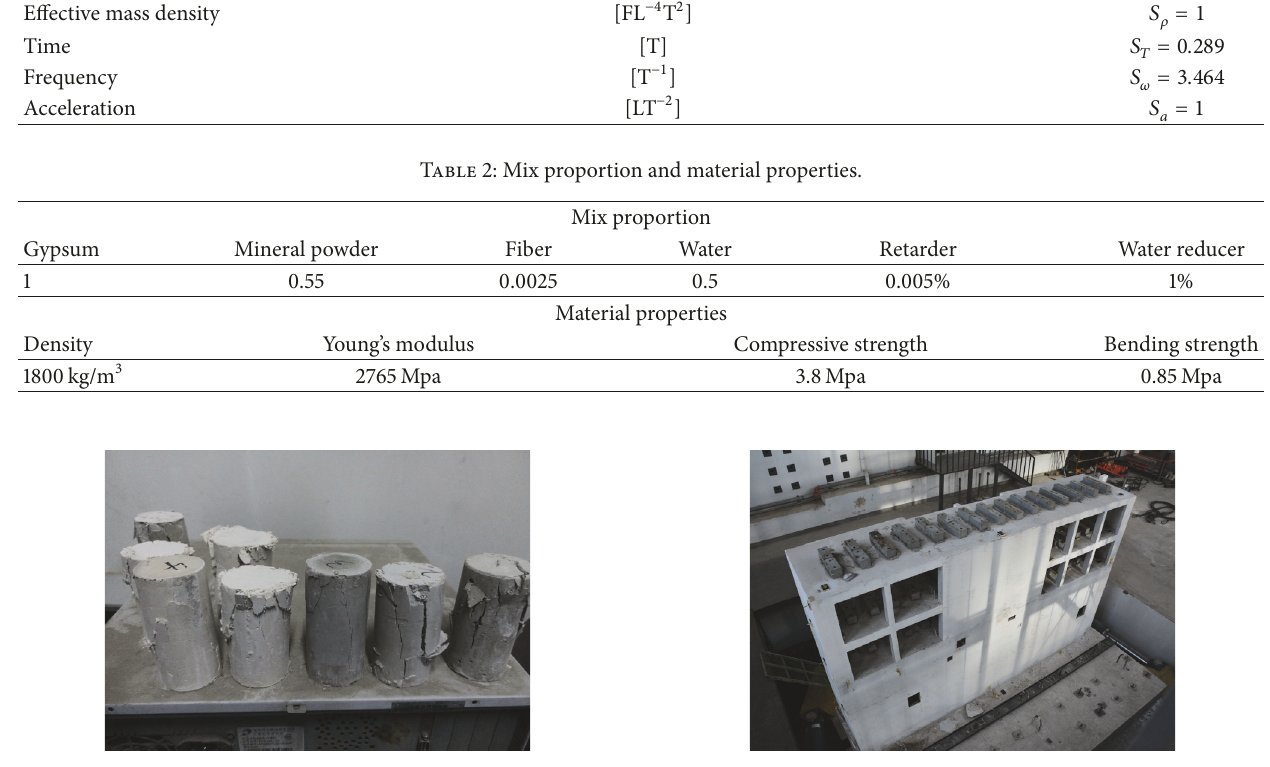
Figure 2: Typical compressive fracture failure modes. Figure 3: Counterweighting the test